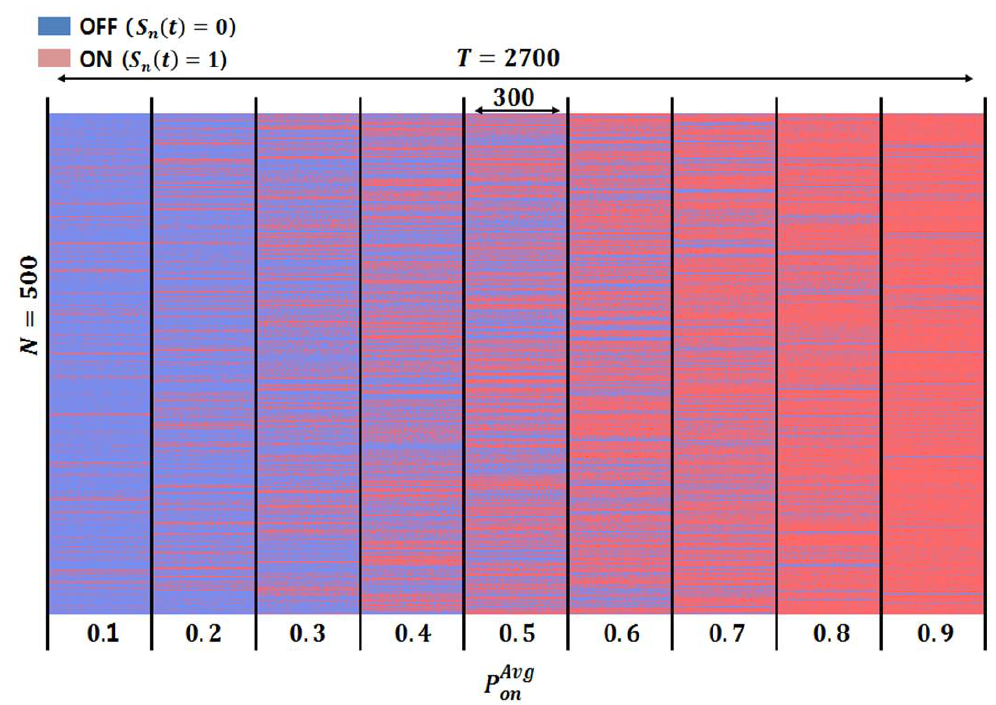
Figure 12. Result of traffic model generation according to the average value of the channel occupancy probability of the